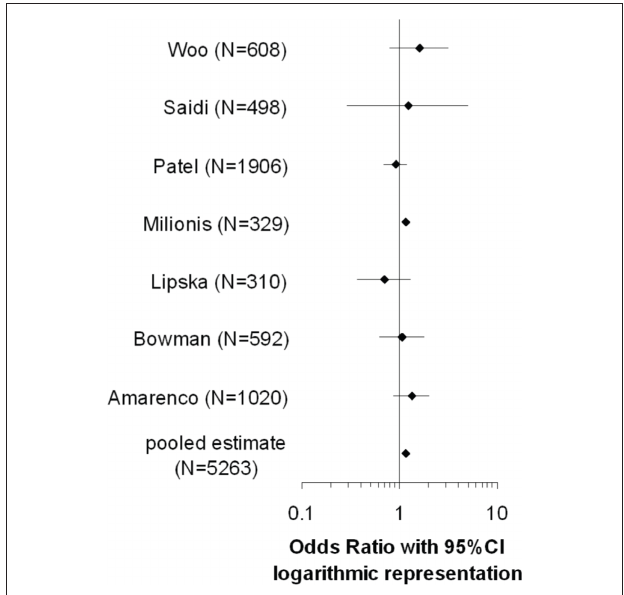
FiguRe 4 | Forrest plot illustrating the odds ratios (95% Ci) of studies included in the